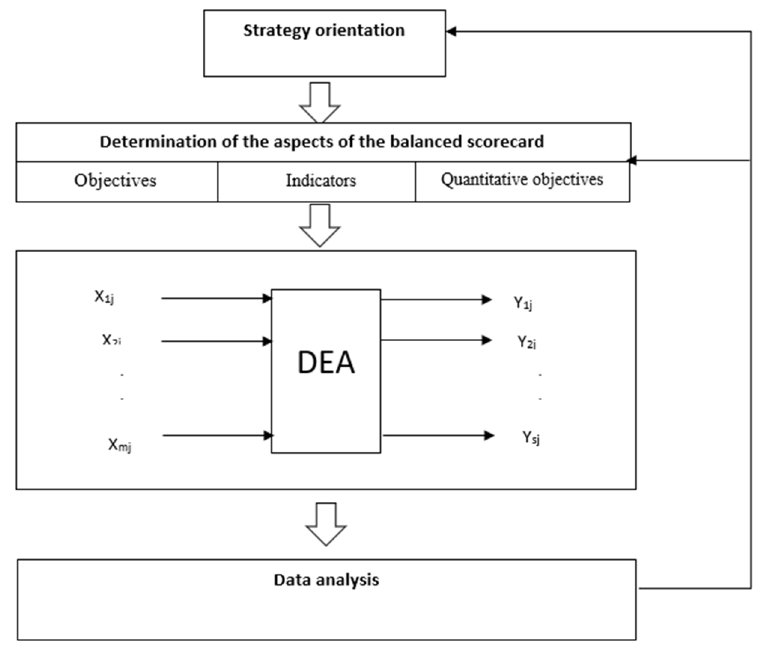
Figure 4. The overall structure of the recommended DEA and BSC integrated